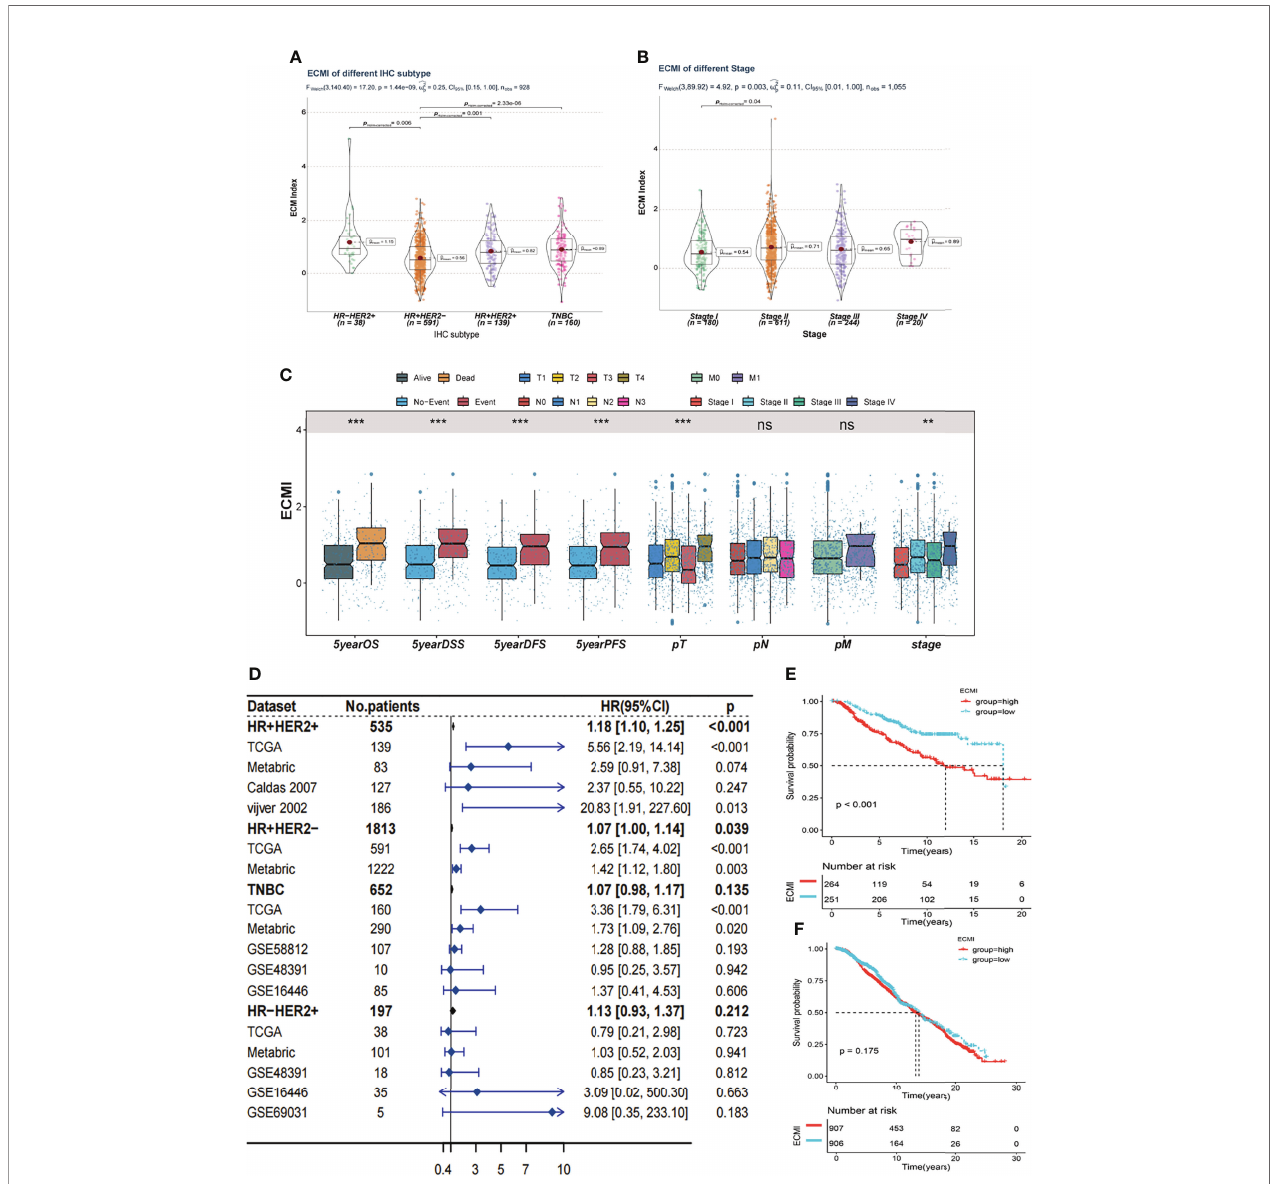
FIGURE 3 | Clinical value of the ECMI. (A) The ECMI levels in four different IHC subtypes in TCGA. (B) The ECMI levels in four different clinical stages in TCGA. (C) Boxplot of the ECM score in different clinical subgroups in TCGA. *p < 0.05, ***p < 0.001, ****p < 0.0001. ns, not statistically signi fi cant. (D) Forestplot was plotted to present the predictive value of the ECMI in each subtype and cohort. (E) Kaplan – Meier survival analysis of the ECMI high group and ECMI low group in merged HR+HER2+ cohort. (F) Kaplan – Meier survival analysis of the ECMI high group and ECMI low group patients in merged HR+HER2-